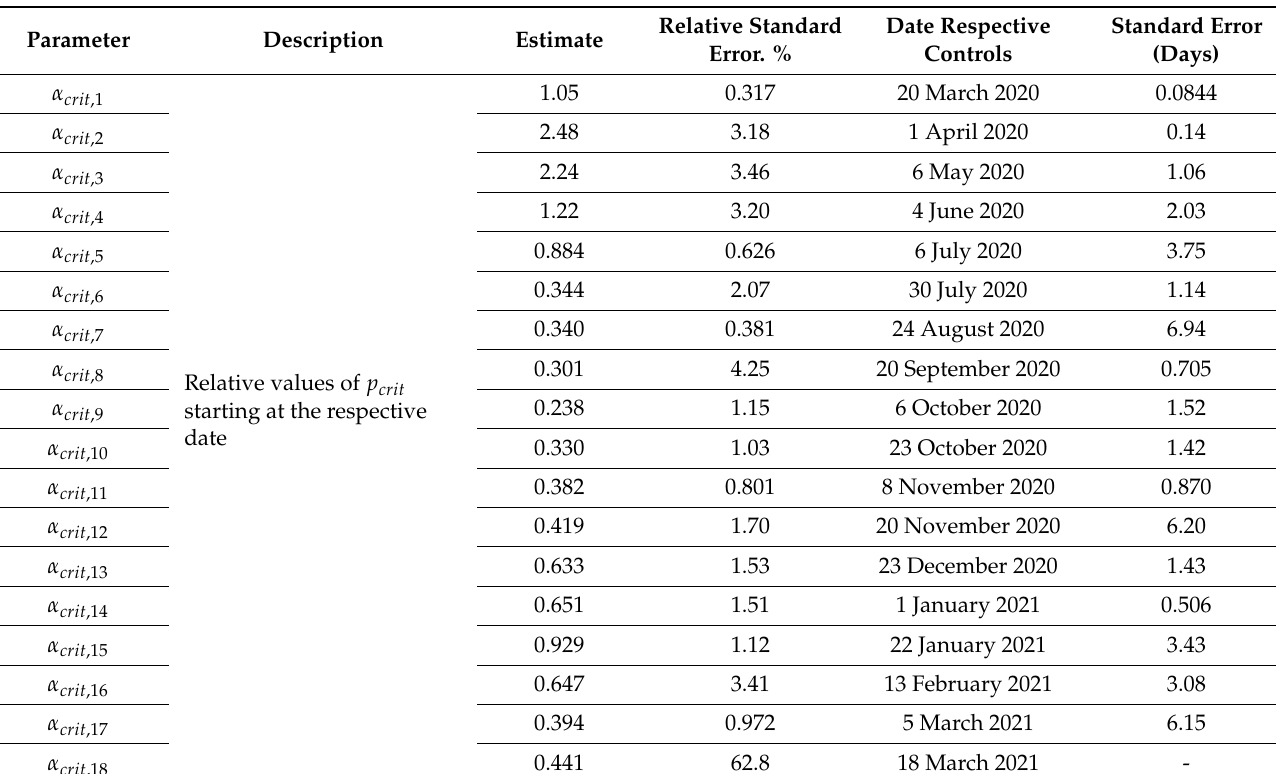
Table A3. Step functions of p crit and p death . We present estimates for the single steps of the functions p crit and p death at the specified dates and respective standard errors. We also provide the standard error of the estimated time point (last